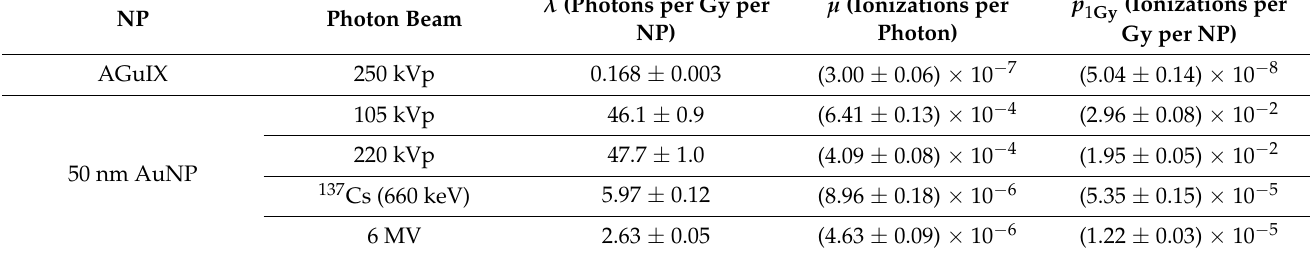
Table 1. Results of λ , µ , and p 1Gy .